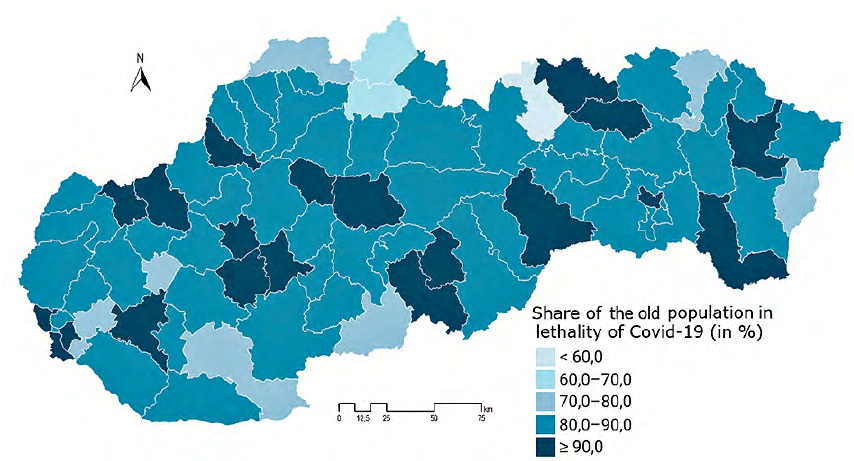
Figure 9. Lethality of Covid-19 of the population in the old (65 and over) age group in districts of Slovakia in 2020